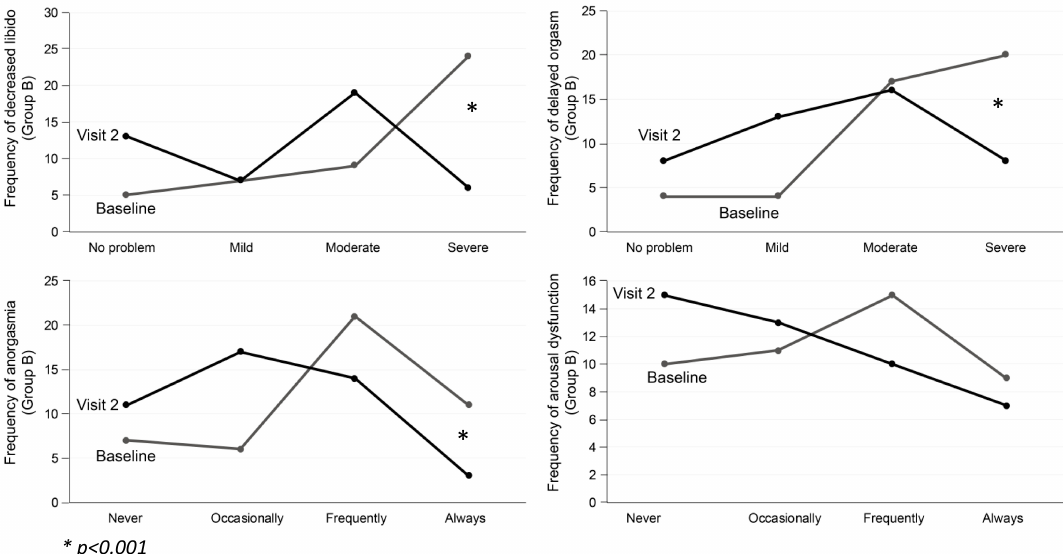
Figure 5. Group B. Patients switched to desvenlafaxine. Changes in sexual functioning at follow-up.